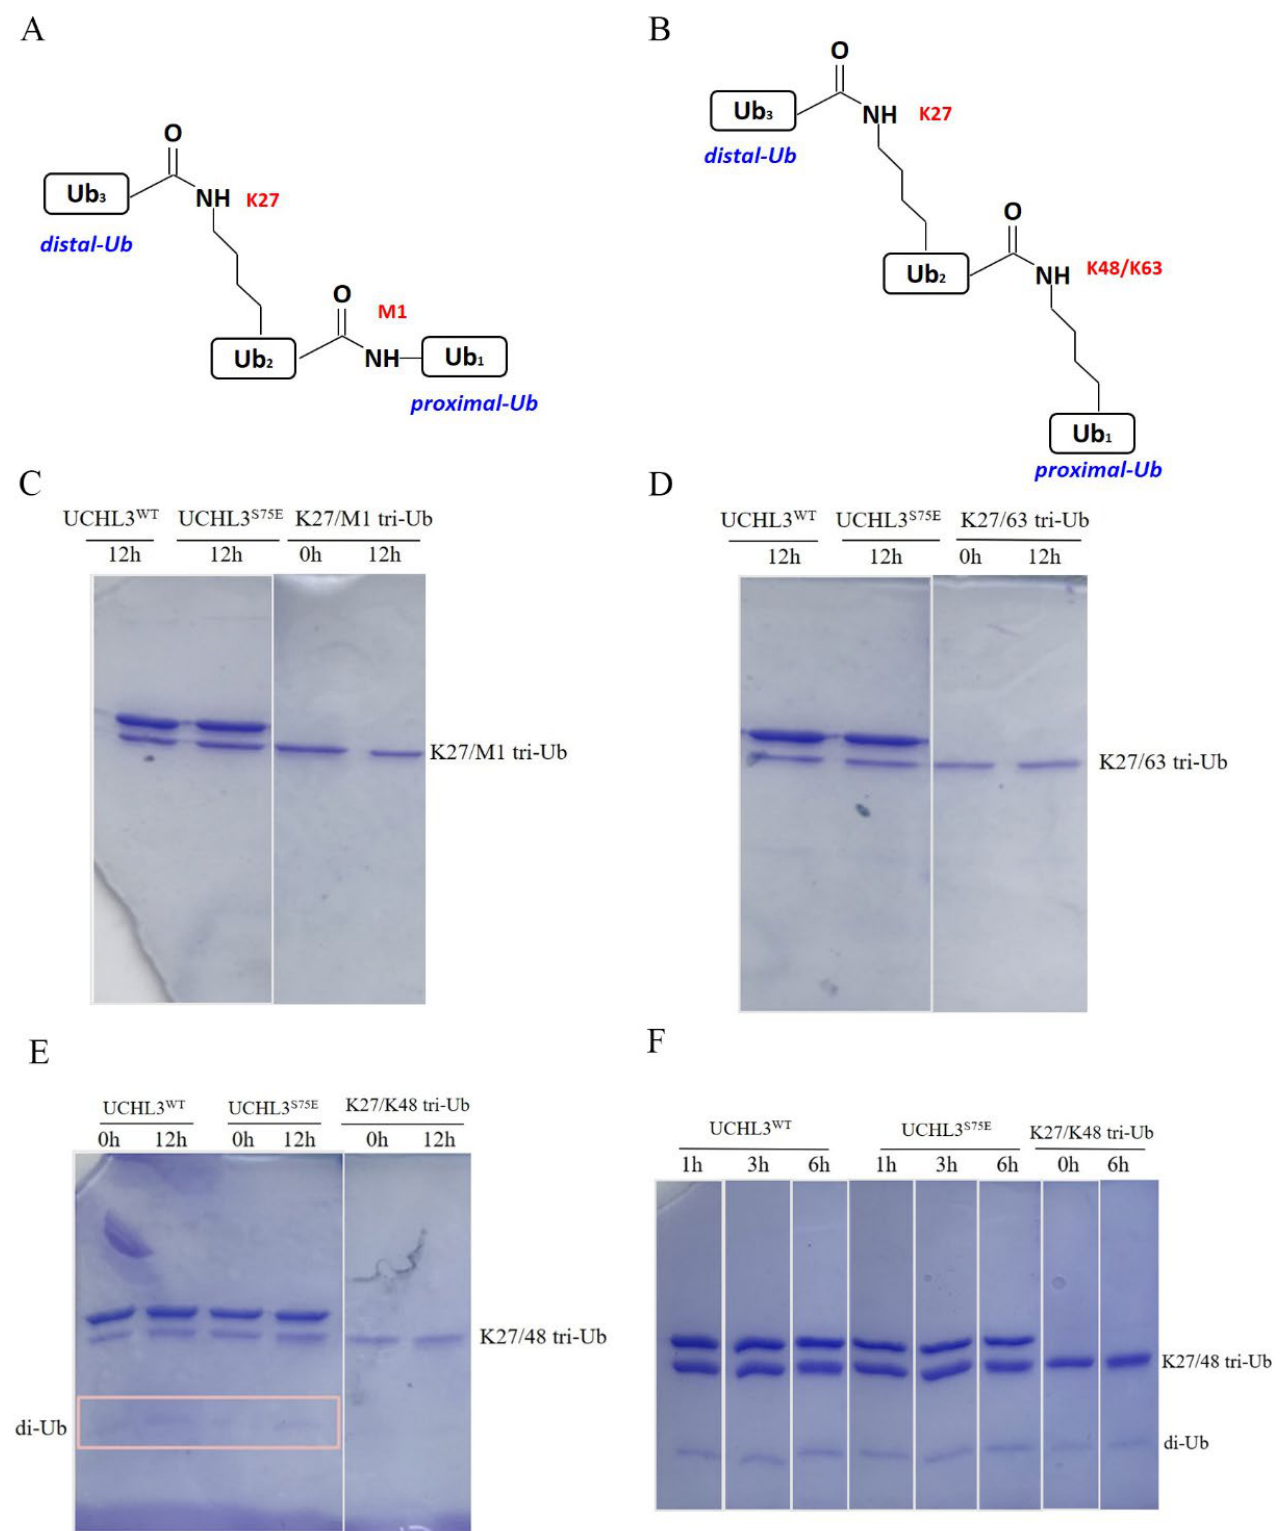
Figure 5. Hydrolysis activity of UCHL3 toward different types of tri-Ub chains. ( A , B ) Pattern diagrams of synthesized K27/M1 tri-Ub, K27/63 tri-Ub, and K27/48 tri-Ub. ( C – F ) UCHL3 S75E or UCHL3 WT was incubated with the substrates, respectively, and the reaction products were fractionated via SDS/PAGE and visualized by Coomassie Blue staining. ( E ) Reaction under 3uM UCHL3 and 5uM K27/48 tri-Ub. ( F ) Reaction under 3uM UCHL3 and 15uM K27/48 tri-Ub.